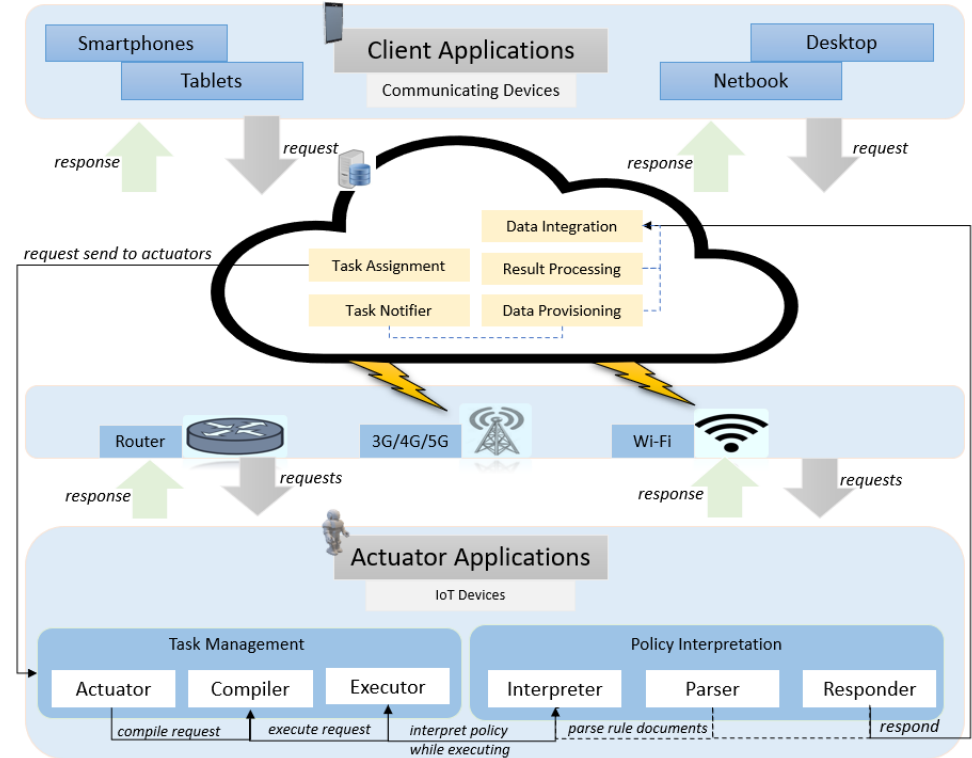
Figure 1. Reference